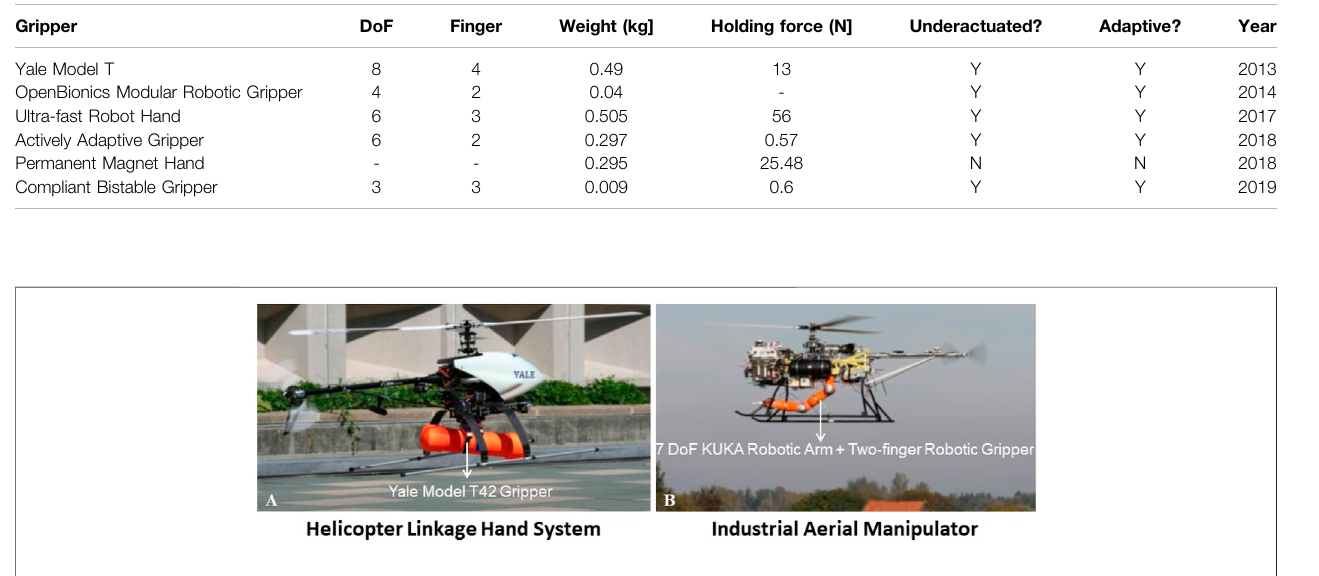
FIGURE5| Helicopter-basedaerialmanipulatorsforaerialgrasping:Sub fi gure (A) presentstheHelicopterLinkageHandSystem(HLHS)developedbyYaleGRAB Lab(PoundsandDollar,2010)whichispresentedin Section.2.2.1 while (B) istheIndustrialAerialManipulatordevelopedbyARCASproject(Kondaketal.,2014)which is presented in Section. 2.2.2